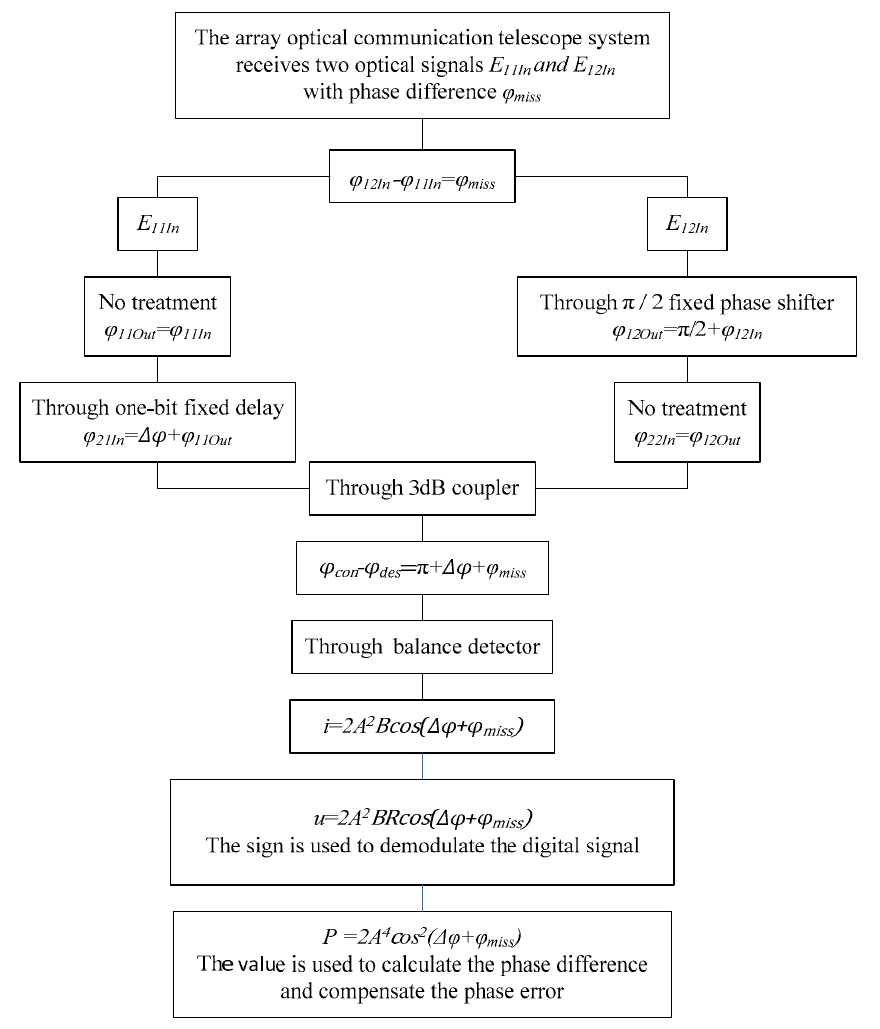
Figure 4. The algorithm principle of digital signal recovery and phase difference detection. Finally, we obtain E con and E des through a 3 dB coupler. The conjugation of the coupler used in this paper is p = 1, The phase difference is obtained as ϕ con − ϕ des = π + ∆ ϕ + ϕ miss . Therefore, the electrical signal of the differential output port of the balance detector is i = 2 A 2 B cos ( ∆ ϕ + ϕ miss ) ; that is, u = 2 A 2 BR cos ( ∆ ϕ + ϕ miss ) . The voltage signal displayed by the oscilloscope is the maximum value. Thus, the value of amplitude can be obtained when the phase difference is zero. The power value collected by the power meter is used as the compensation factor. The relationship is P = U 2 /2 R between the power and voltage of the pure resistance circuit, and R takes 1 in the simulation. Therefore, the mathematical relationship with P is established as (cid:16) (cid:17) P − 1 ϕ miss = 1 arccos . 2 2 A 4